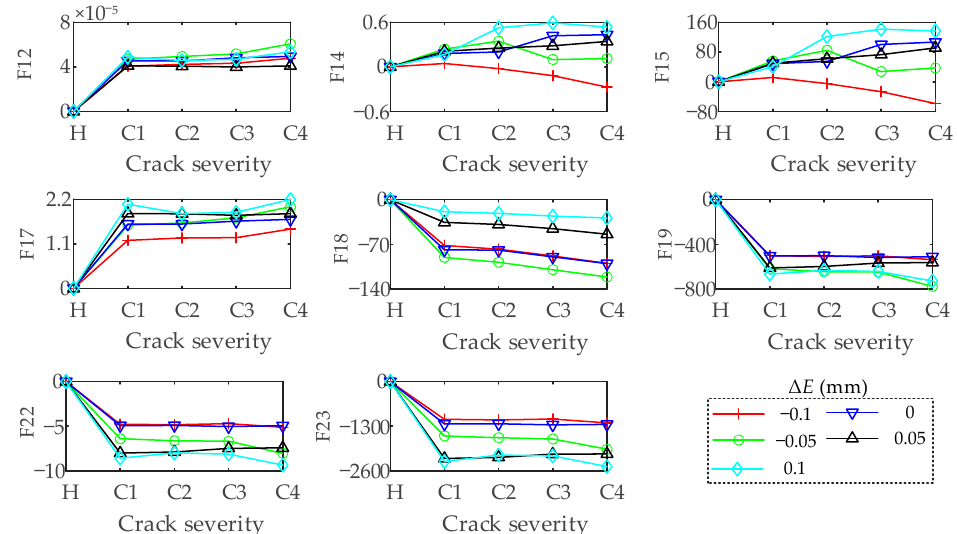
Figure 24. Under the influence of offset error, the fluctuation of frequency-domain indicators relative to their respective healthy condition values under different degrees of cracks.